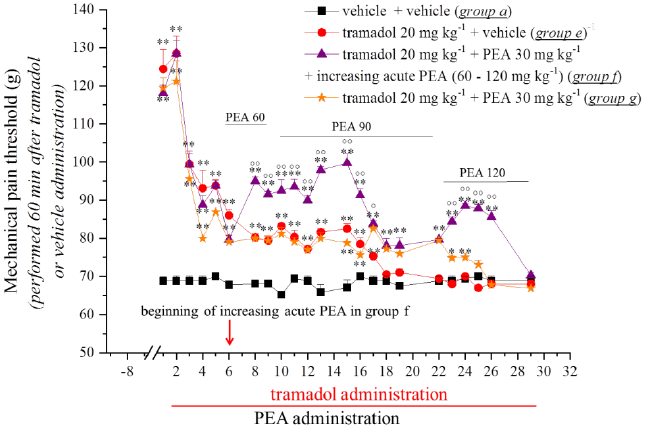
Figure 2. Effect of repeated administration of PEA on the onset of tramadol tolerance and analgesia. Pre-emptive PEA (30 mg kg − 1 ; Groups f and g) or the vehicle (Groups a and e) was orally administered daily (in the evening) for the duration of the experiment, starting on Day − 8. On Day 1, daily, acute tramadol treatment (20 mg kg −1 s.c.) started. From Day 6, Group f received an additional acute daily PEA treatment (60 – 120 mg kg −1 ) in co-administration with the opioid. The pain threshold measurements (paw pressure test) were conducted in the morning, 16 h after pre-emptive PEA ad- ministration and 60 min after tramadol injection. The results are expressed as the mean ± S.E.M. of values from 12 rats analysed in two different experimental sets. Statistical analysis was one-way ANOVA followed by Bonferroni’s post hoc comparison. * p < 0.05 and ** p < 0.01 vs. vehicle + vehicle; ° p < 0.05 and °° p < 0.01 vs. tramadol + vehicle.